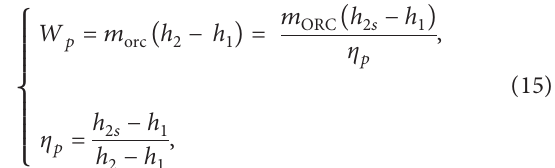
Figure 5: T-S diagram of